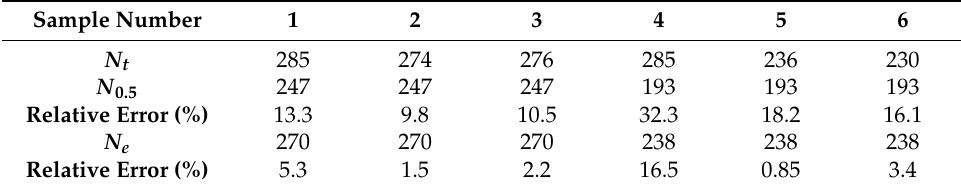
Table 8. The number of cuts corresponding to the failure